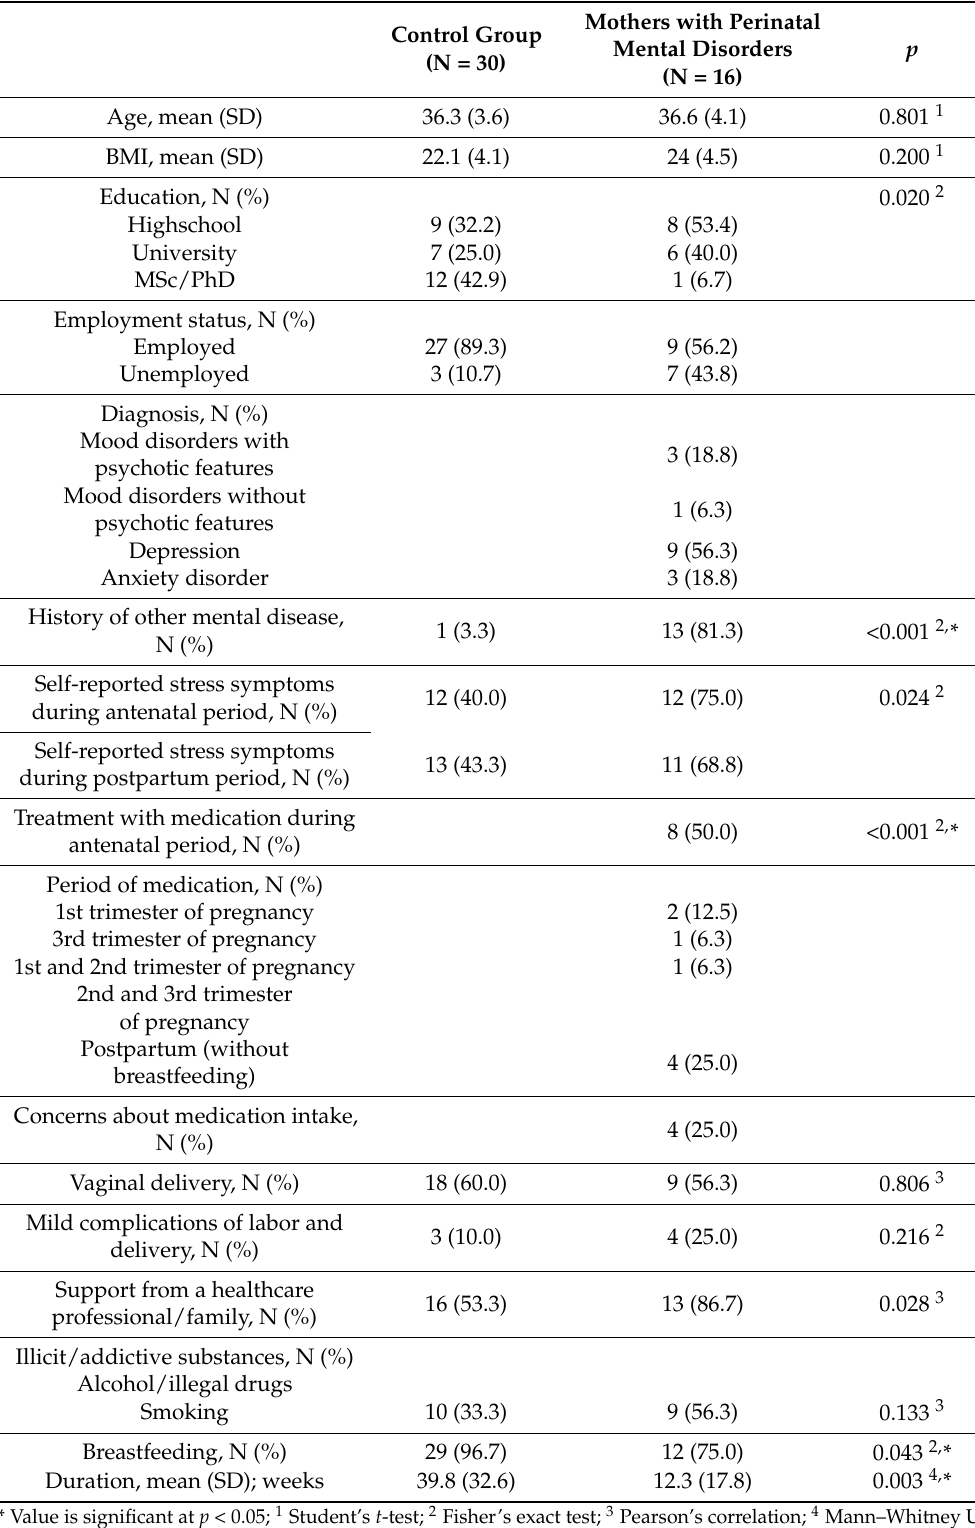
Table 1. Maternal characteristics (N =